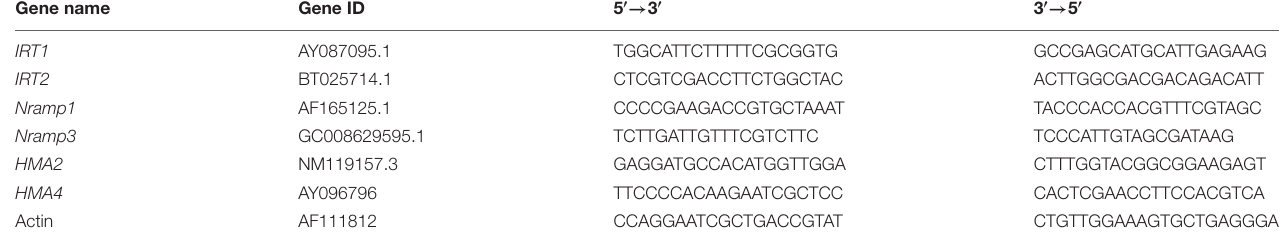
Frontiers in Plant Science |